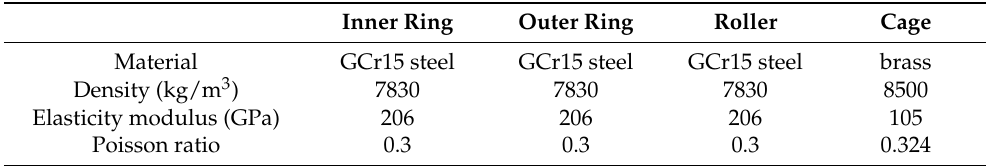
Table 1. The material parameters of NU306